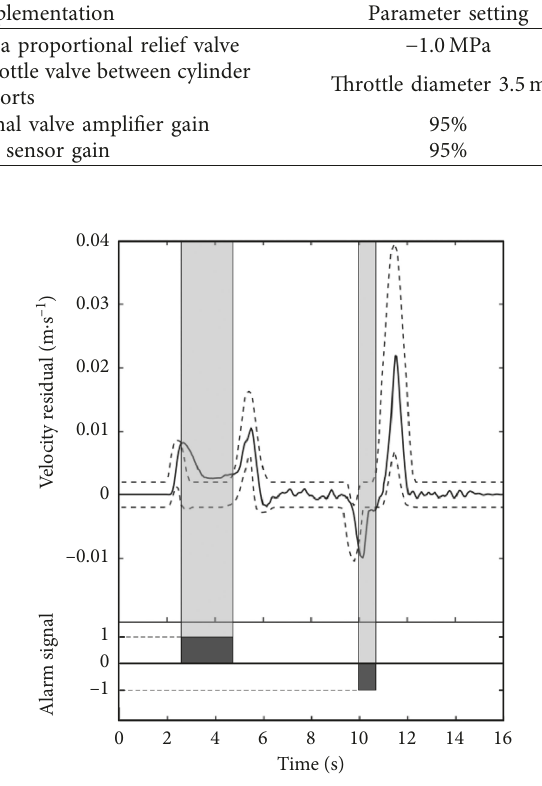
Figure 7: Residuals of proportional fault and alarm